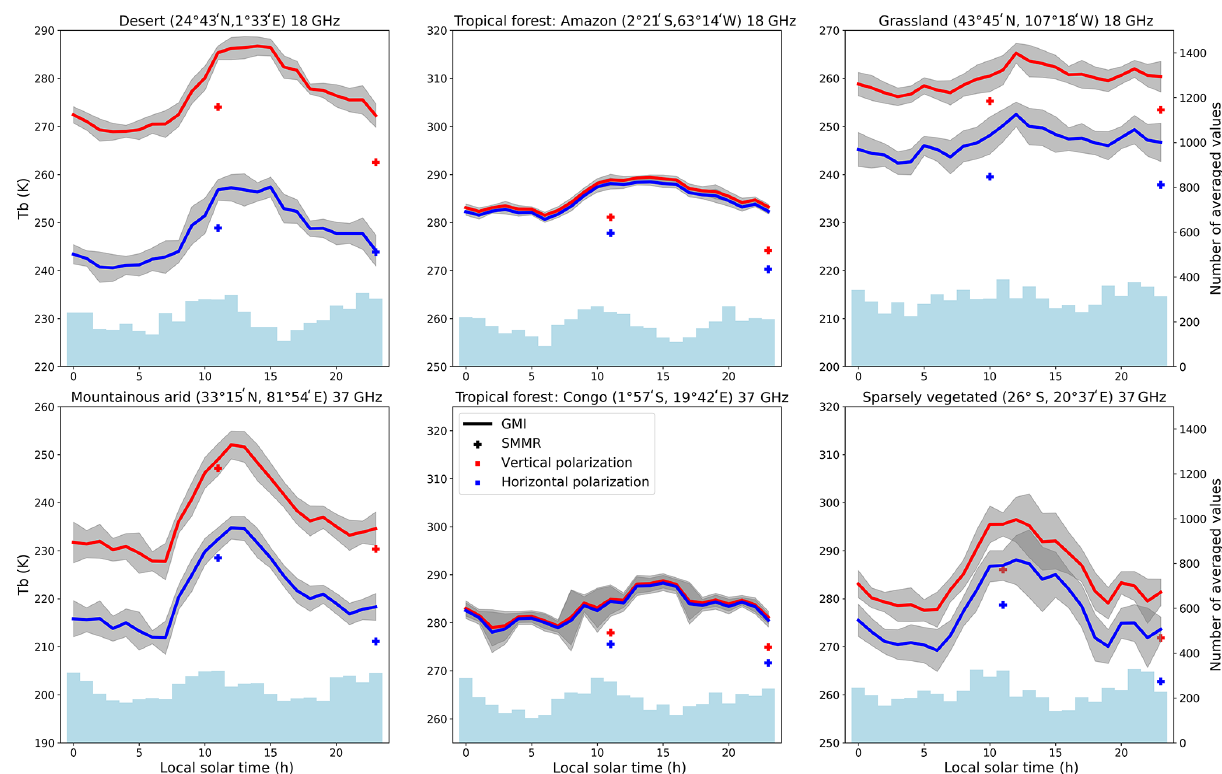
Figure 1. Diurnal cycles from GMI compared to SMMR values at different frequencies and locations averaged for the months of January and February (horizontal polarization in blue and vertical in red). Measurements are averaged over 25 grid cells and by hour, with the standard deviation of each average temperature in the diurnal cycle and the associated number of measurements displayed